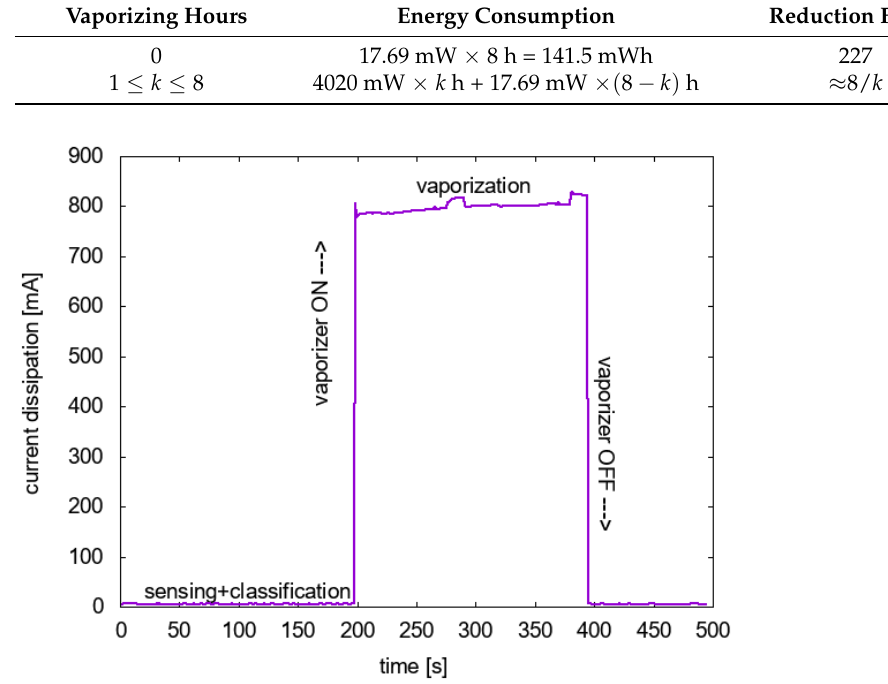
Figure 11. Current dissipation comparison between sensing + classification and